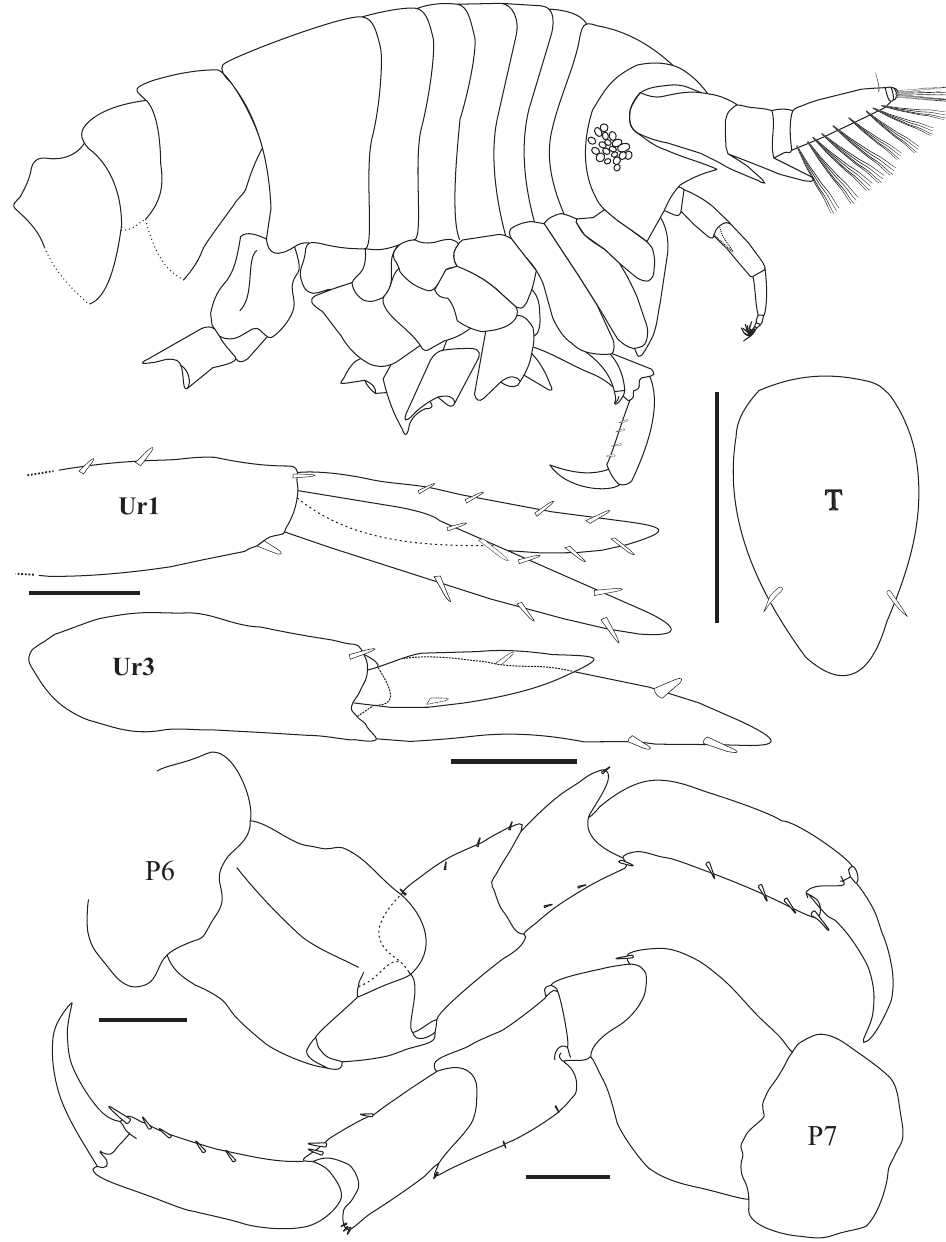
Fig . 5. – Curidia wakabarae n. sp., reVizee Benthos sCore/northeast, male, 0.91 mm, atol das rocas, station #103a (3.829ºs; 33.673ºW), doCean 13500. Curidia wakabarae sp.nov., holotype, female, 2.42mm, Fernando de noronha Chain: Pequeno island,